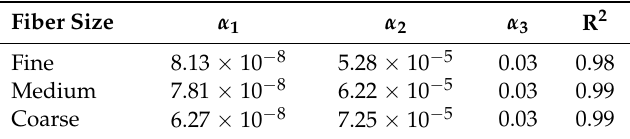
Table 4. Regression equation coefficients to calculate the thermal conductivity of the fiber mat as a function of mat anhydrous density (Equation (3)).